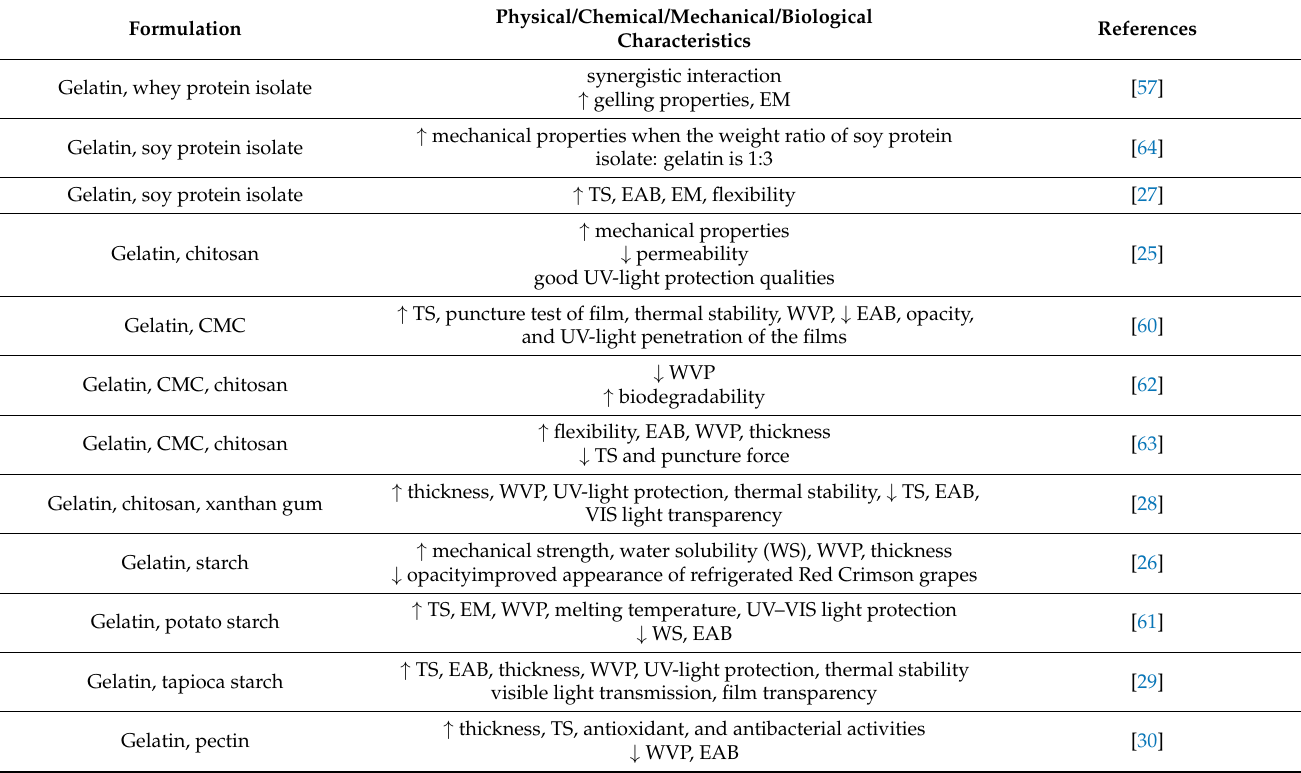
Table 1. The characteristics of the gelatin–biopolymers